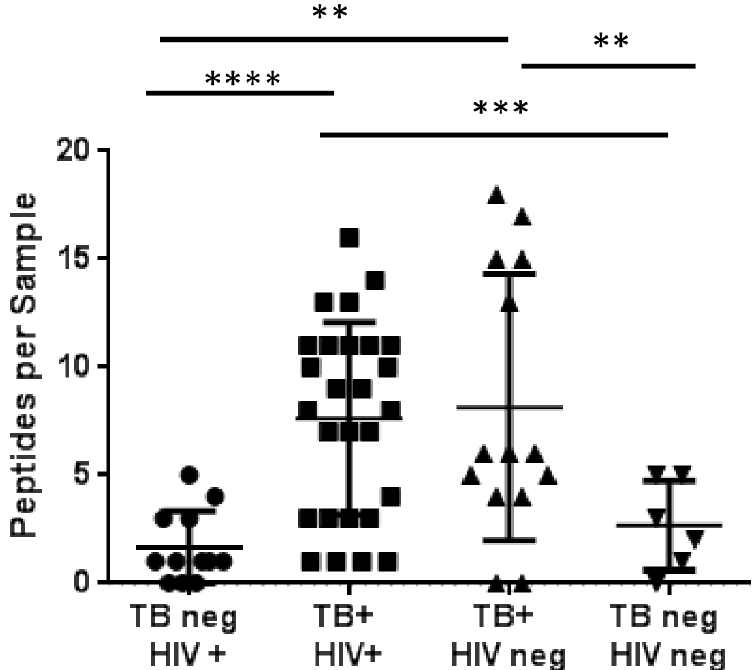
Figure 3. Scatter plot showing the total number of peptides identified in each sample class broken down by TB and HIV status. P- values from unpaired t-tests are represented as follows: **p , 0.01, ***p , 0.001, ****p , 0.0001.